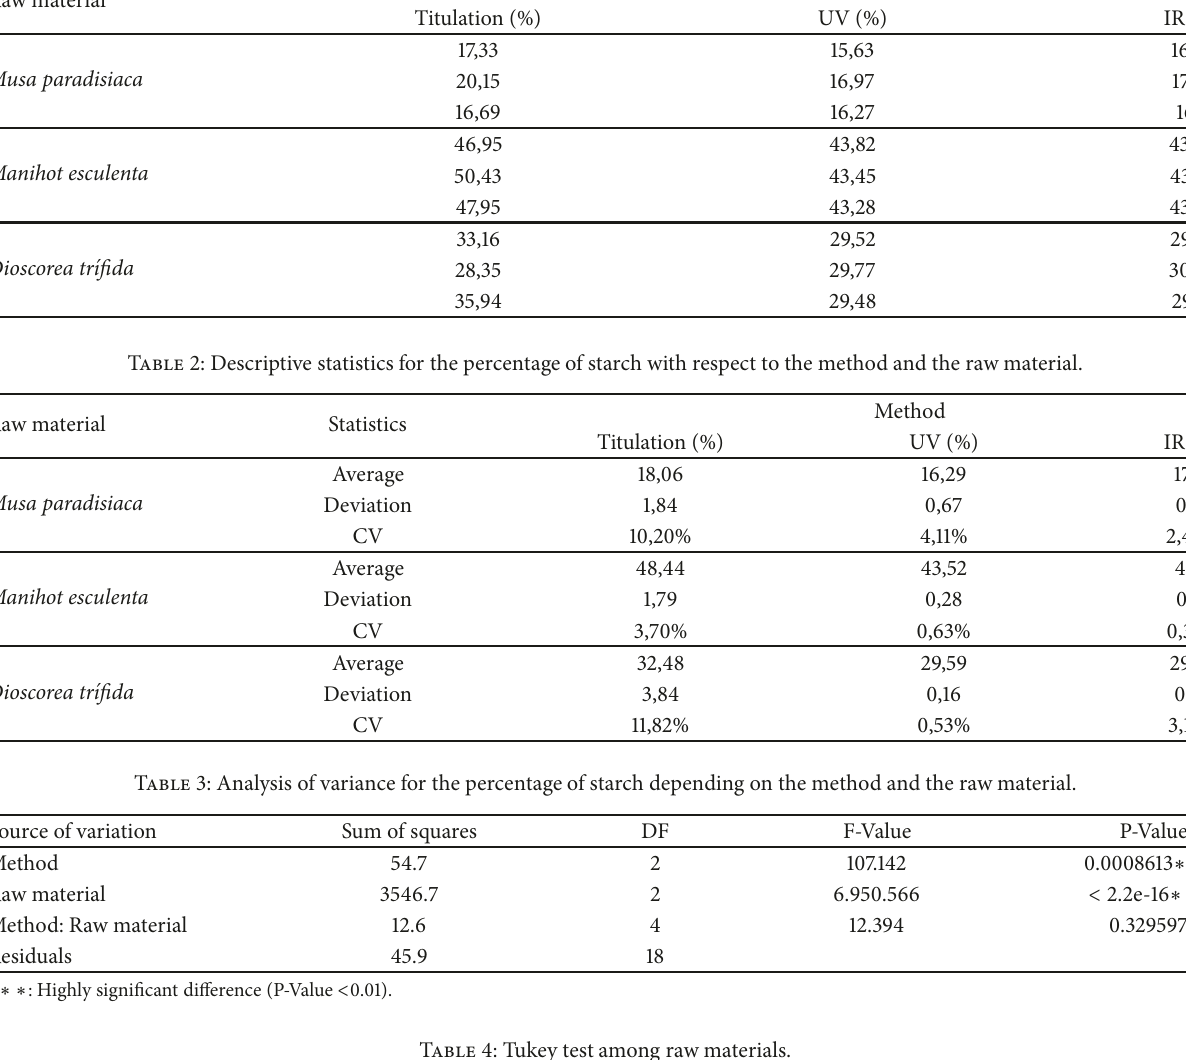
Table 1: Starch percentages for the different raw materials using the different methods. Raw material